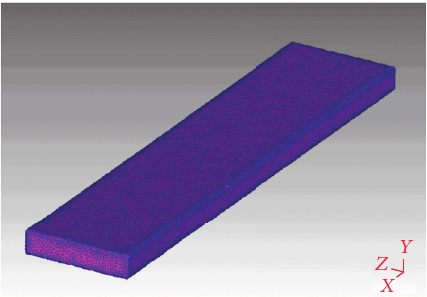
Figure 1: Finite element model.